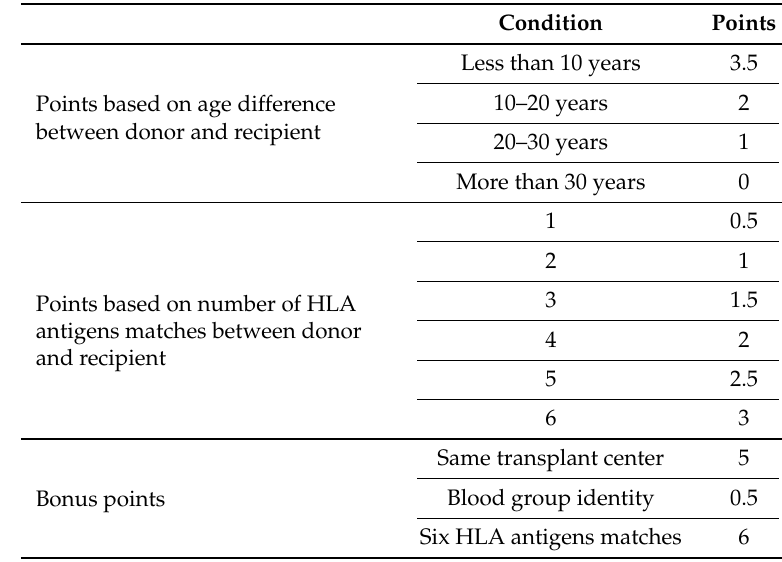
Same transplant center Blood group